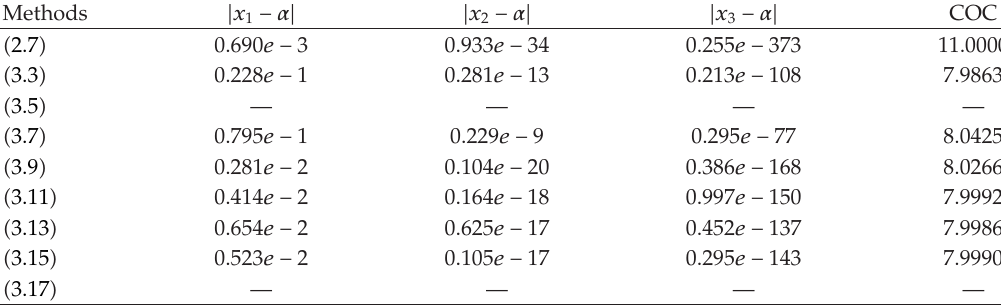
Table 1: Errors occurring in the estimates of the root of (cid:3) 4.1 (cid:4) by the methods described.